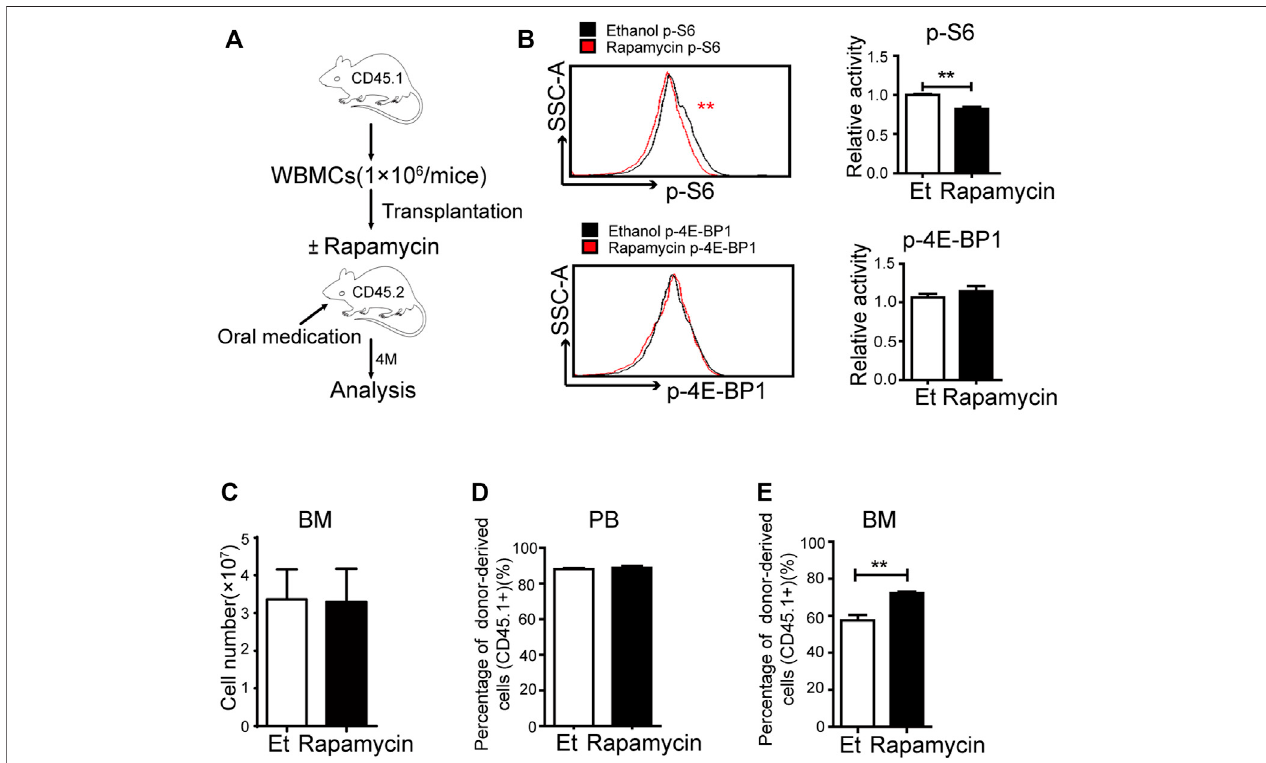
FIGURE 2 | Oral administration of rapamycin enhanced BM cells engraftment upon transplantation (A) Experiment design with rapamycin treatment of transplantation mouse model with BM cells (CD45.1), n = 3, days = 120, dose = 2 mg/kg/day (B) Fluorescence intensity of p-S6 (upper panel) and p-4E-BP1 (lower panel) in BM cells of recipient mice treated by rapamycin or ethanol (control, Et) for 4 months, n =3 (C) Absolute number ofbone marrow cells (D) Percentage of donor- derived cells (CD45.1 + ) in the PB in two groups at 4 months; n = 3 (E) Percentage of donor-derived cells in the BM in two groups at 4 months; n =